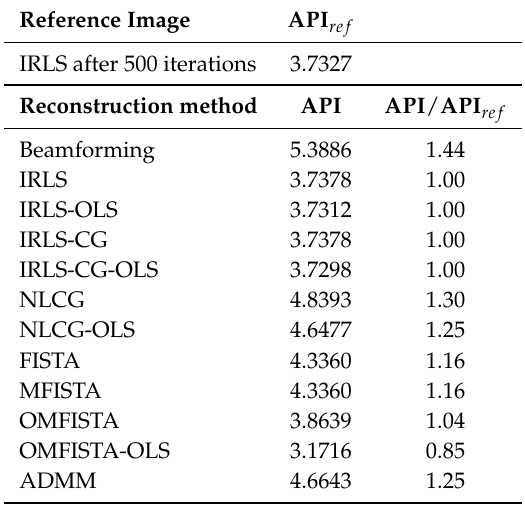
Table 4. API values for reconstructed images after 30 iterations—Distinct real